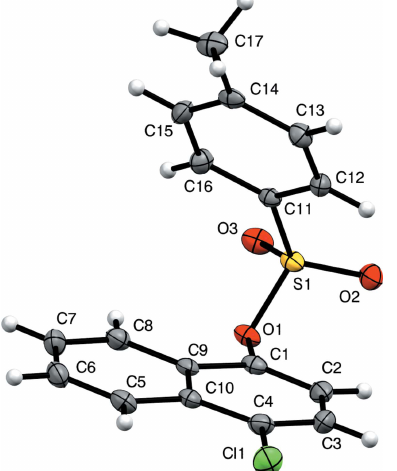
Figure 1 The molecular structure of the title compound with displacement ellipsoids drawn at the 50% probability level.